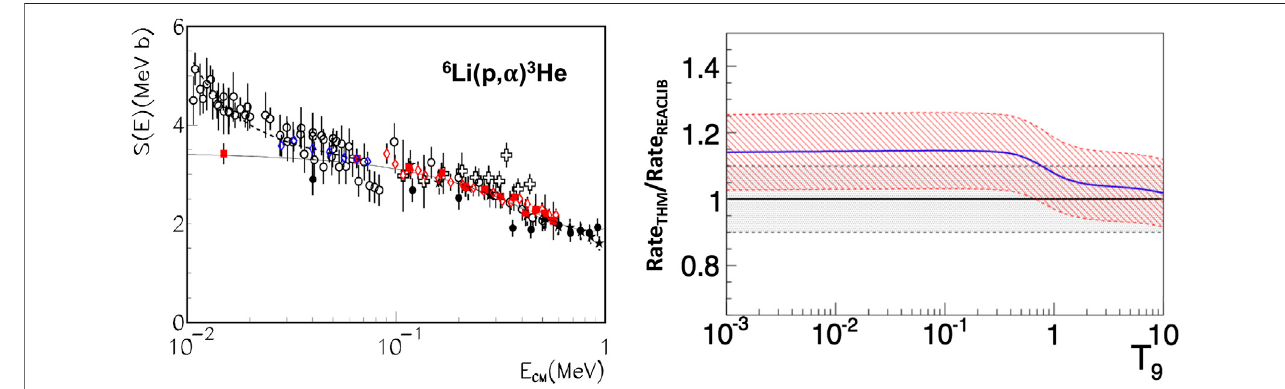
FIGURE 1 | Left panel S(E)-factor for the 6 Li(p, α ) 3 He reaction. TH data from Lamia et al. (2013) (red squares) normalized to the available direct measurements of Elwyn et al.(1979), Kwon et al.(1989), Cruz et al. (2008). Blackdots representTH data from Tumino et al. (2003). The fulllineisthe result ofthe polynomial fi tofTH data. Dashed line is the result of the fi t of Engstler et al. (1992) and Cruz et al. (2005) data to extract the electron screening potential. Right panel The ratio between the THM reaction rate of Lamia et al. (2013) compared with the one reported in Cyburt et al. (2010) [Figures adapted from Lamia et al.